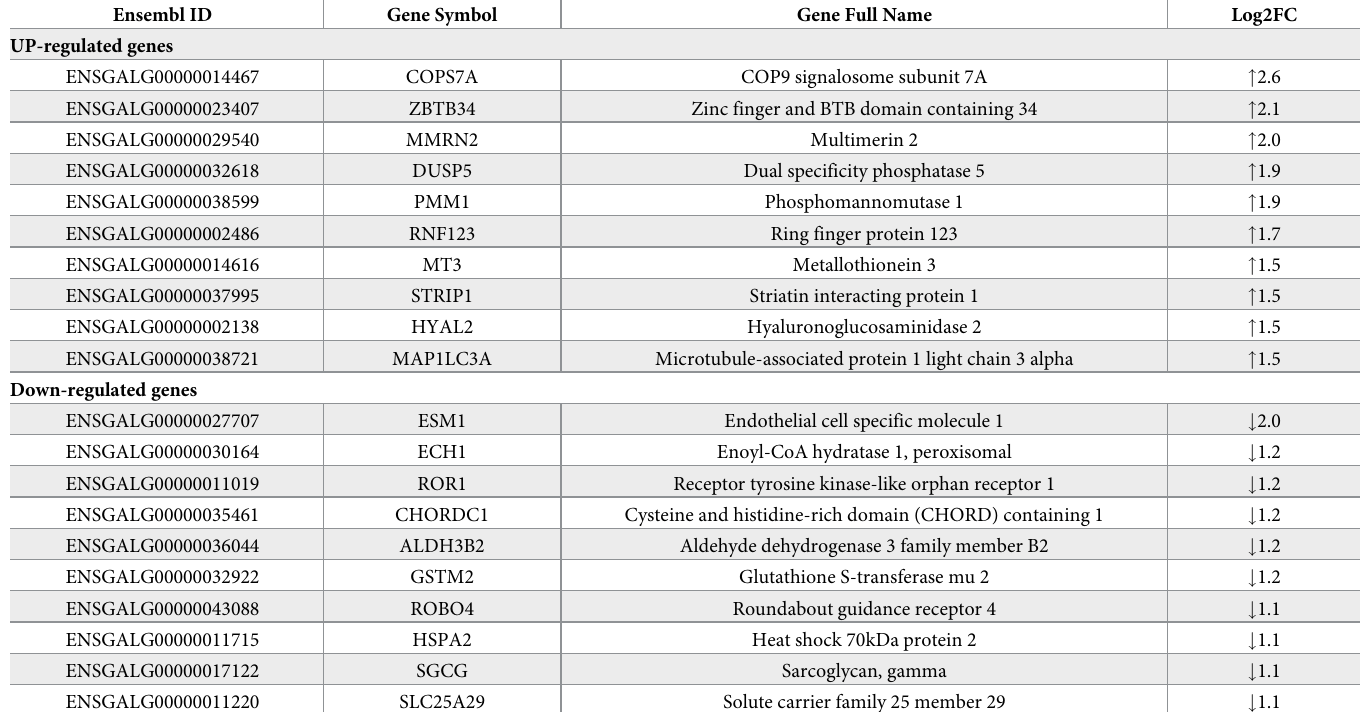
Table 3. Top 10 up- and down-regulated genes in HFE group.